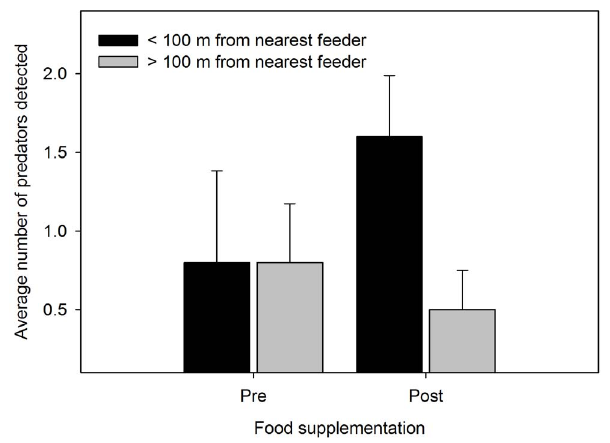
Figure 5. Average number of nest predators detected near and far from feeders pre- and post-supplementation. Average number ( 6 SE) of potential avian and mammalian nest predators detected within 50 m of point-count stations , 100 m from feeders (black bars) and . 100 m from feeders (grey bars) for the periods both pre- and post-food supplementation. The average number of potential nest predators detected was similar prior to food supplementation at point count stations , 100 m and . 100 m from feeders. After food supplementation began, the average number of potential nest predators detected post-food supplementation increased at point- count stations located , 100 m from feeders (black bars) but decreased at point-count stations . 100 m from feeders (gray bars).